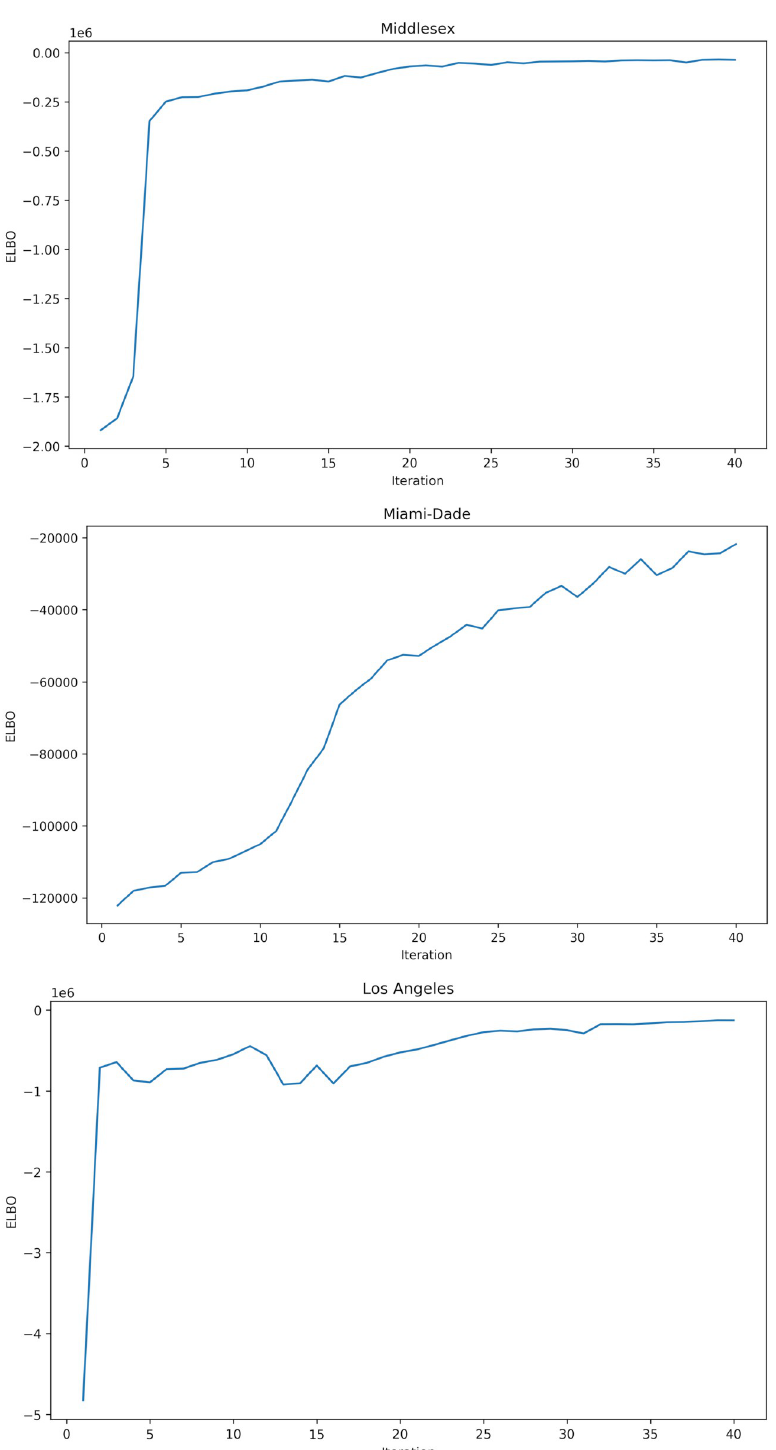
Fig 17. Convergence curves, showing the ELBO at each iteration of optimization. We see that parameter inference has converged within the allocated computation budget.